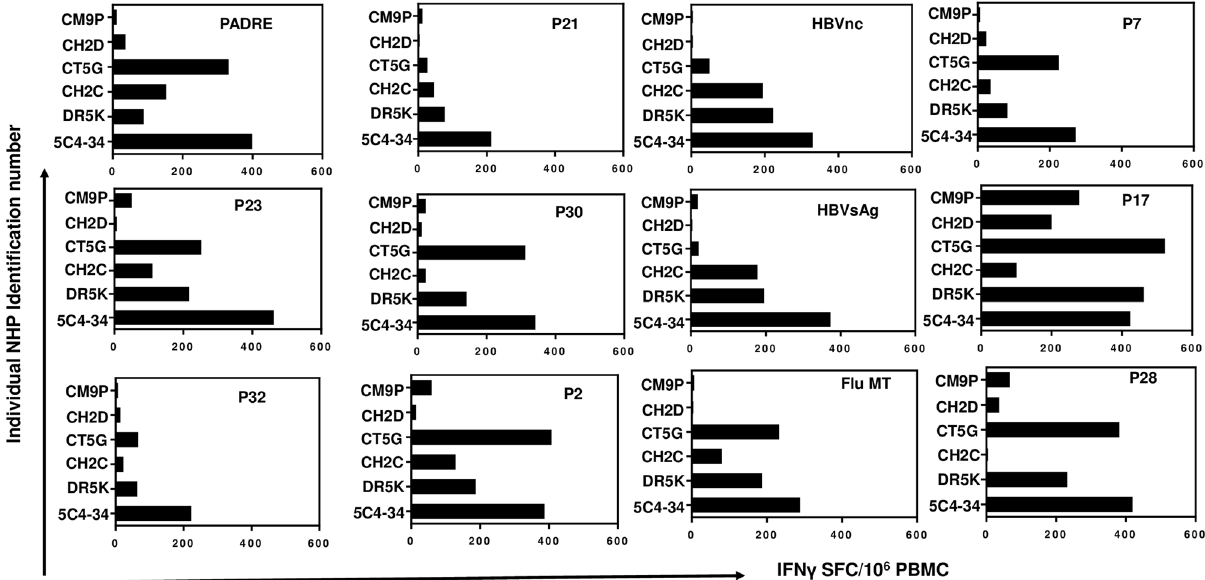
Fig. 4 AV-1980R/A activated a broad repertoire of Th cells speci fi c to individual Th epitopes comprising MultiTEP in NHPs. Data presented as the number of IFN γ cytokine-producing cells (SFCs) speci fi c to individual peptides minus the background level. All peptides were used at 20 μ g/ml.